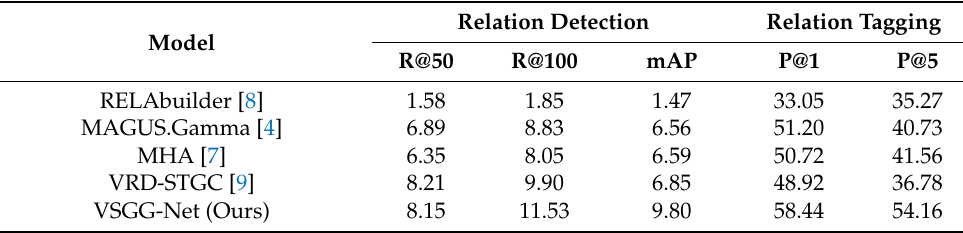
Table 6. Comparison of the proposed method with state-of-the-art models on VidOR validation set.